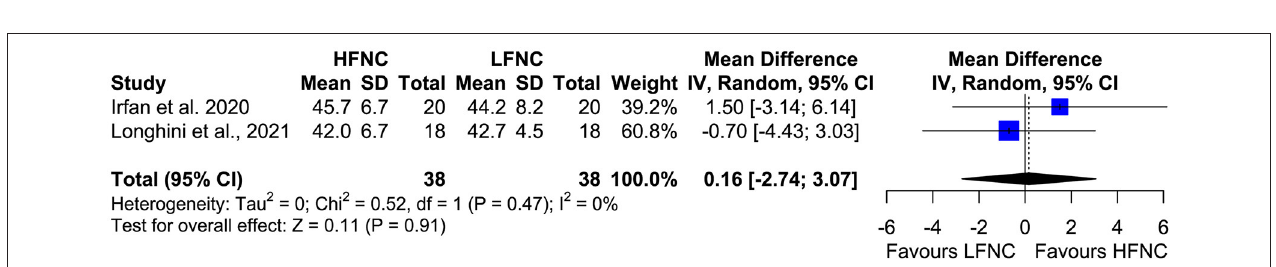
method, where FiO2 is highly variable and affected by the breathing pattern of a patient while the CPAP effect is absent (3,